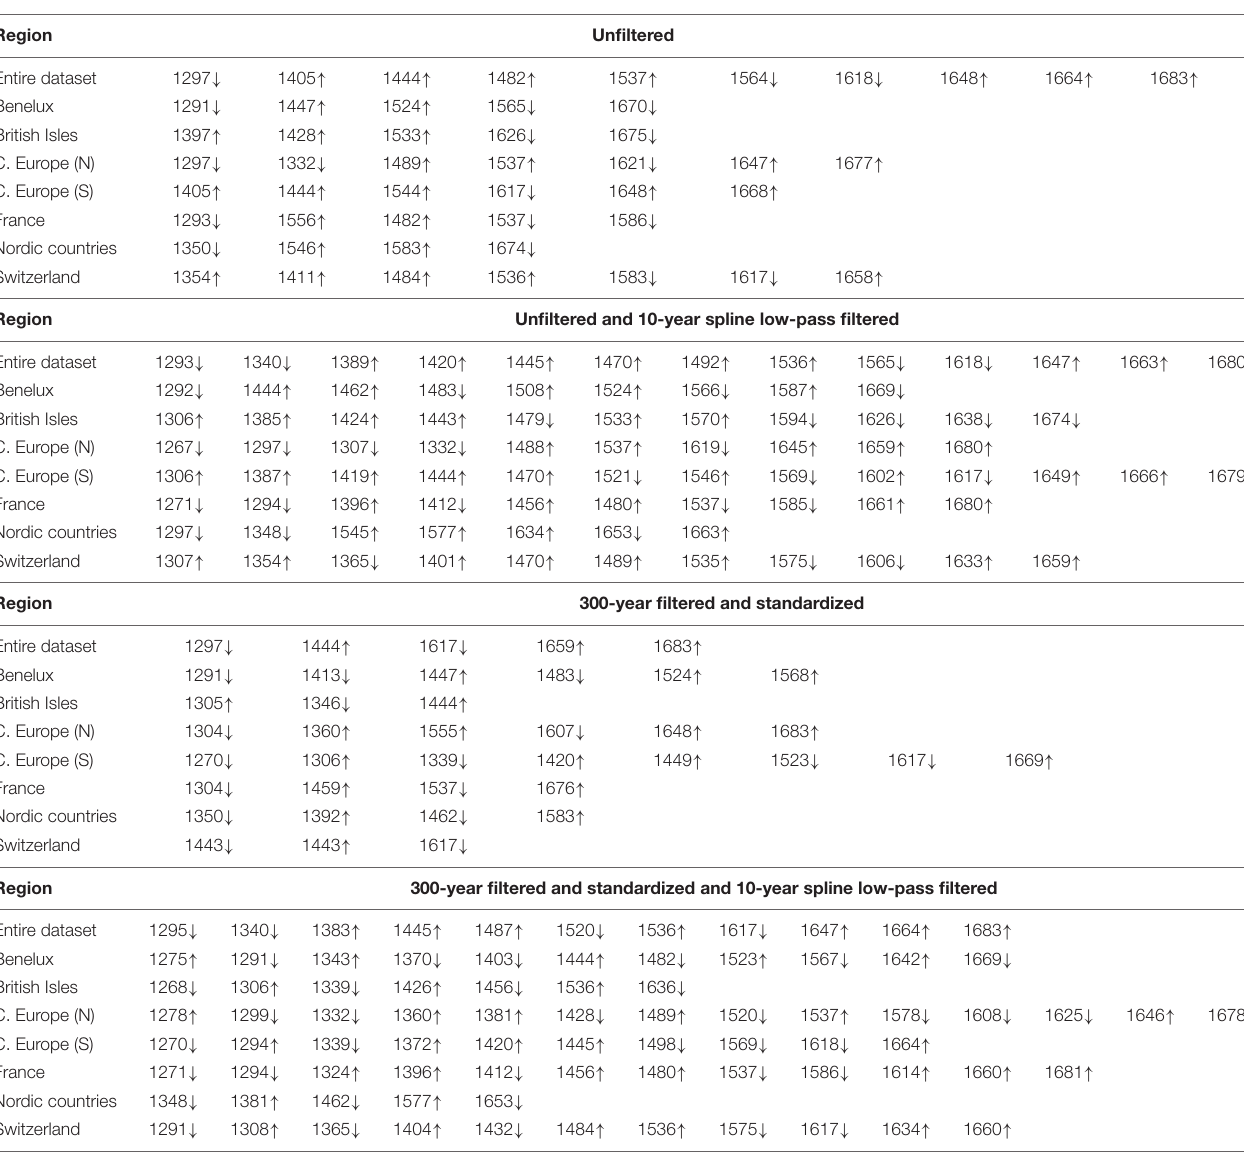
TABLE 3 | List, in chronological order, of significant regime shifts in the unfiltered regional subsets of felling dates as well as in the full dataset.